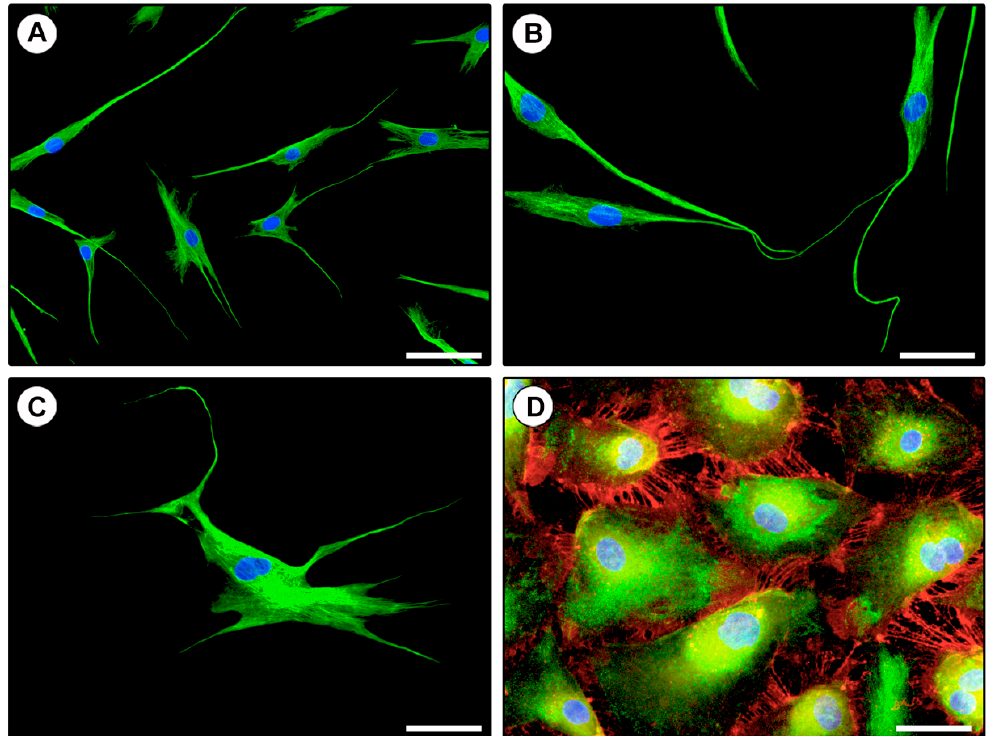
Figure 4. Verification of the immunophenotypic profile of in vitro cultured CD31 − /CD34+ and CD31+ immunomagnetically selected cells by CD31/CD34 double immunofluorescence. ( A – C ) Representative fluorescent microscopic images of CD31 − /CD34+ immunomagnetically selected cells double immunostained for CD34 (green) and CD31 (red). The cells express only CD34 and are morphologically identifiable as telocytes with typical telopodes. The cell body of telocytes varies in shape, being oval, triangular, or spindle-shaped, and gives rise to a variable number of telopodes. ( B ) Note the presence of telocytes establishing intercellular contacts with their telopodes. ( D ) Representative fluorescent image of CD31+ immunomagnetically selected cells double immunostained for CD34 (green) and CD31 (red). All cells coexpress CD31 and CD34 and display the typical polygonal cobblestone-like morphology of endothelial cells. Note the distinctive localization of the CD31 antigen at regions of intercellular contacts. Nuclei are counterstained in blue with 4 ′ ,6-diamidino-2-phenylindole (DAPI). Original magnification: ×20 ( A ), ×40 ( B – D ). Scale bar: 100 µm ( A ), 50 µm ( B – D ).